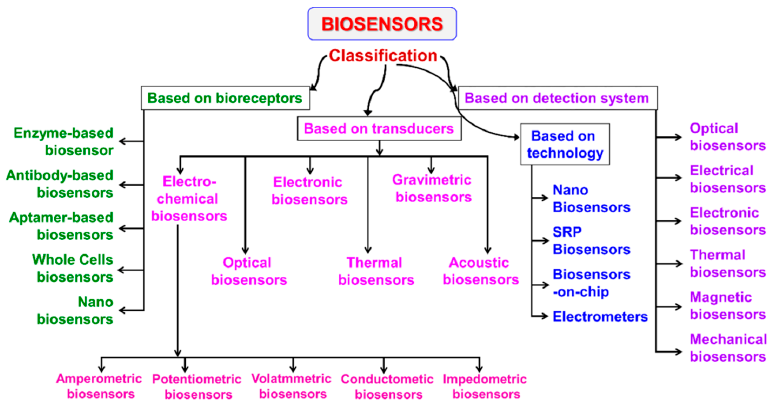
Figure 1. Classification of biosensors based on various bioreceptors and transducers used [16].